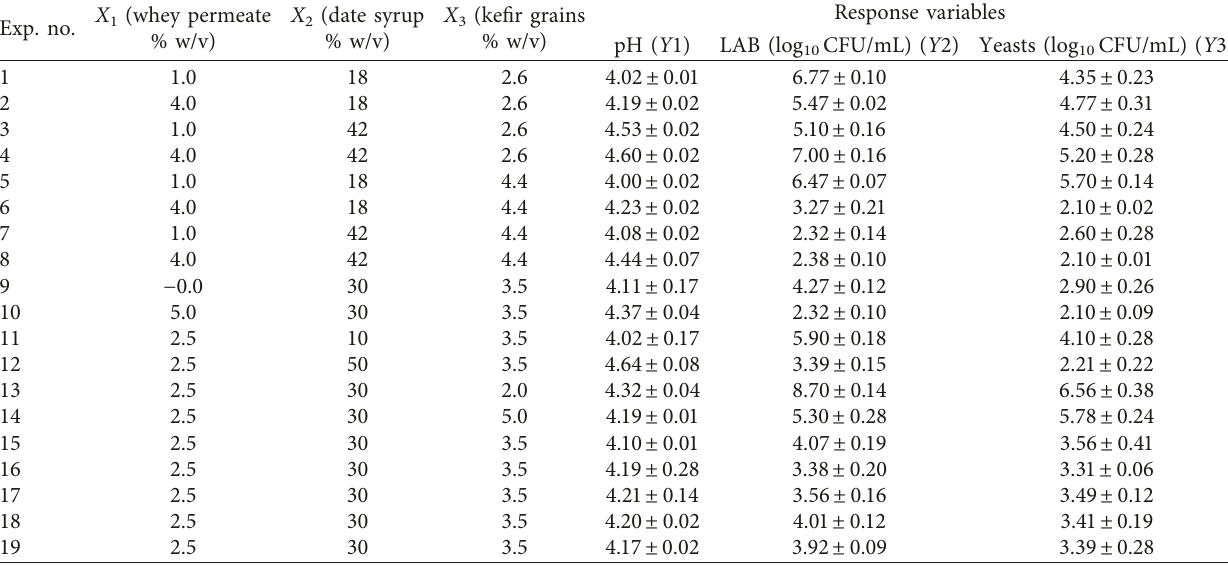
Table 2: Matrix of the central composite design (CCD) and observed responses for the response variables (pH, LAB, and yeasts). X 1 (whey permeate Exp. no. % w/v)